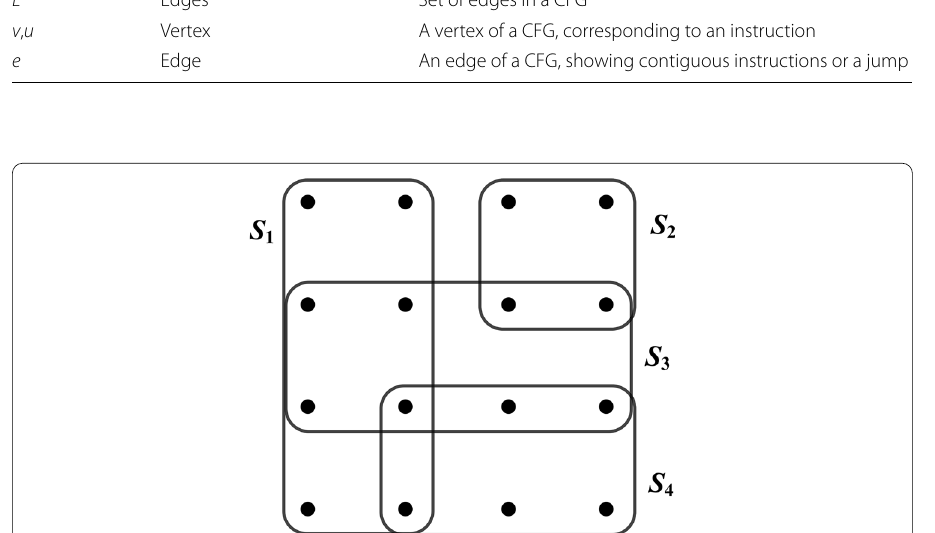
Fig. 3 An instance of set cover. { S 1 , S 2 , S 4 } is the minimum-size subfamily that covers all elements of the input family (black